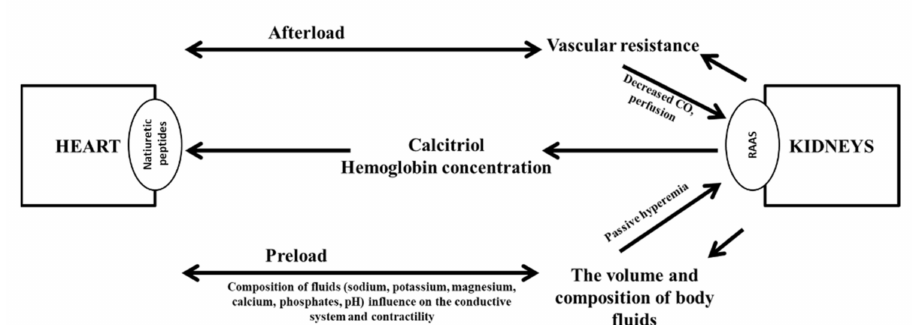
Figure 1. Basic mechanisms underlying the mutual dependencies of heart and kidney functions. CO, cardiac output; RAAS, renin-angiotensin-aldosterone system. A figure prepared by the authors on the basis of pathophysiological issues described by Rangaswami et al. [8]. The figure shows the influence of heart and kidney function on the afterload and preload values. The decrease in cardiac output due to heart failure causes renal hypoperfusion. The sympathetic nervous system, the renin-angiotensin-aldosterone system and the release of vasopressin are activated in order to increase systemic vascular resistance and circulating blood volume. Increased venous pressure causes renal congestion, which additionally impairs their function. A decrease in glomerular filtration causes not only hypervolemia (increased preload), but also unfavorable changes in ion concentrations, which affects the contractility of cardiomyocytes. In addition, along with the deteriorating kidney function, disturbances in calcium-phosphate metabolism increase and the synthesis of erythropoietin is impaired, which also adversely affects the function of blood vessels and the heart muscle.